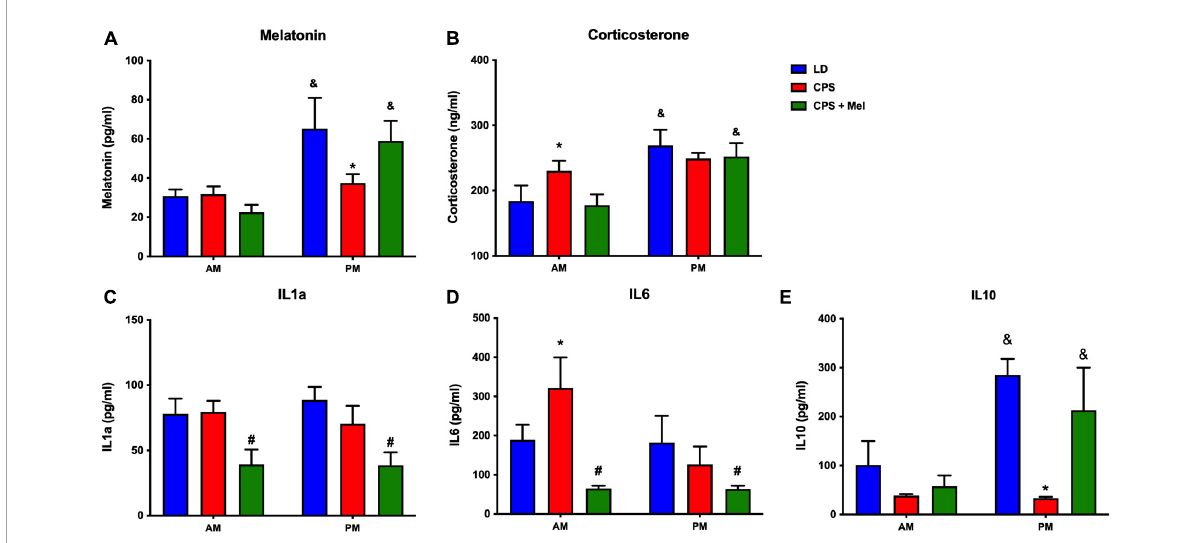
FIGURE2 Effect of maternal melatonin supplementation on AM–PM levels of plasma melatonin, and corticosterone, in female 90-day-old offspring (A) and plasma cytokine levels (B) . Plasma was collected at 11 and 23 h ( n = 6–7 per clock time) in females gestated in LD (blue bars), CPS (red bars), and CPS + Mel (green bars) conditions. Data are mean ± SEM. *Different to LD and CPS+Mel, # Different LD to CPS ( P < 0.05 two-way ANOVA and Tukey); & Different to AM period ( P < 0.05 unpaired t -test; two-way ANOVA, and